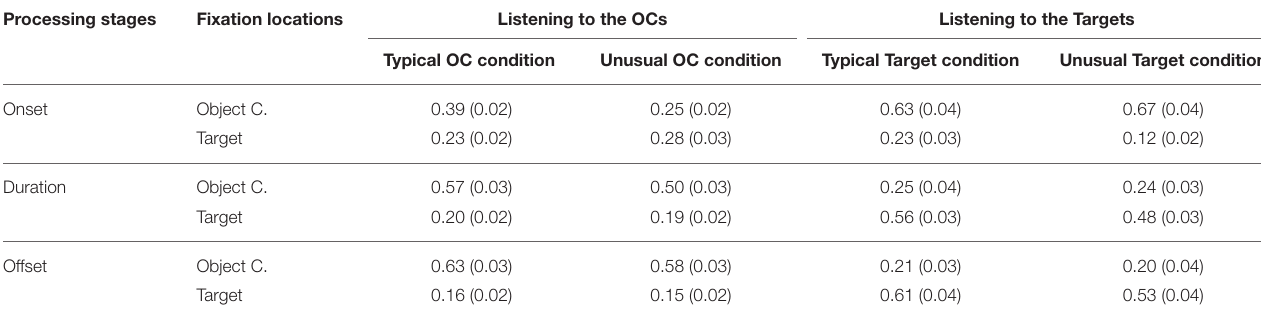
Processing stages